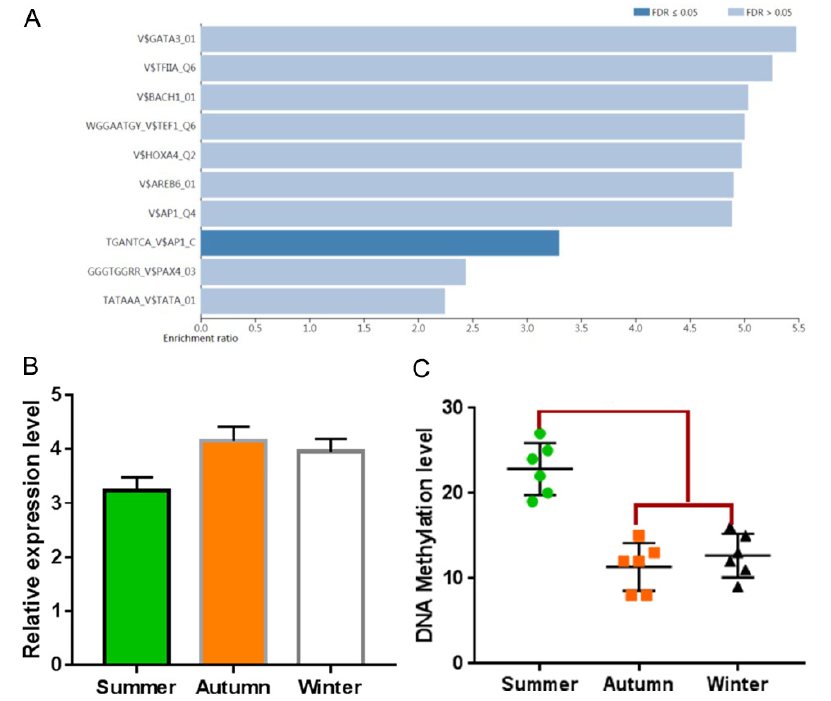
Figure 8. Transcription factor enrichment analysis and verification. ( A ) the transcription factor enrichment analysis of genes in the PPI network; ( B ) expression of AP1 genes in the three groups; ( C ) methylation difference analysis of core genes.